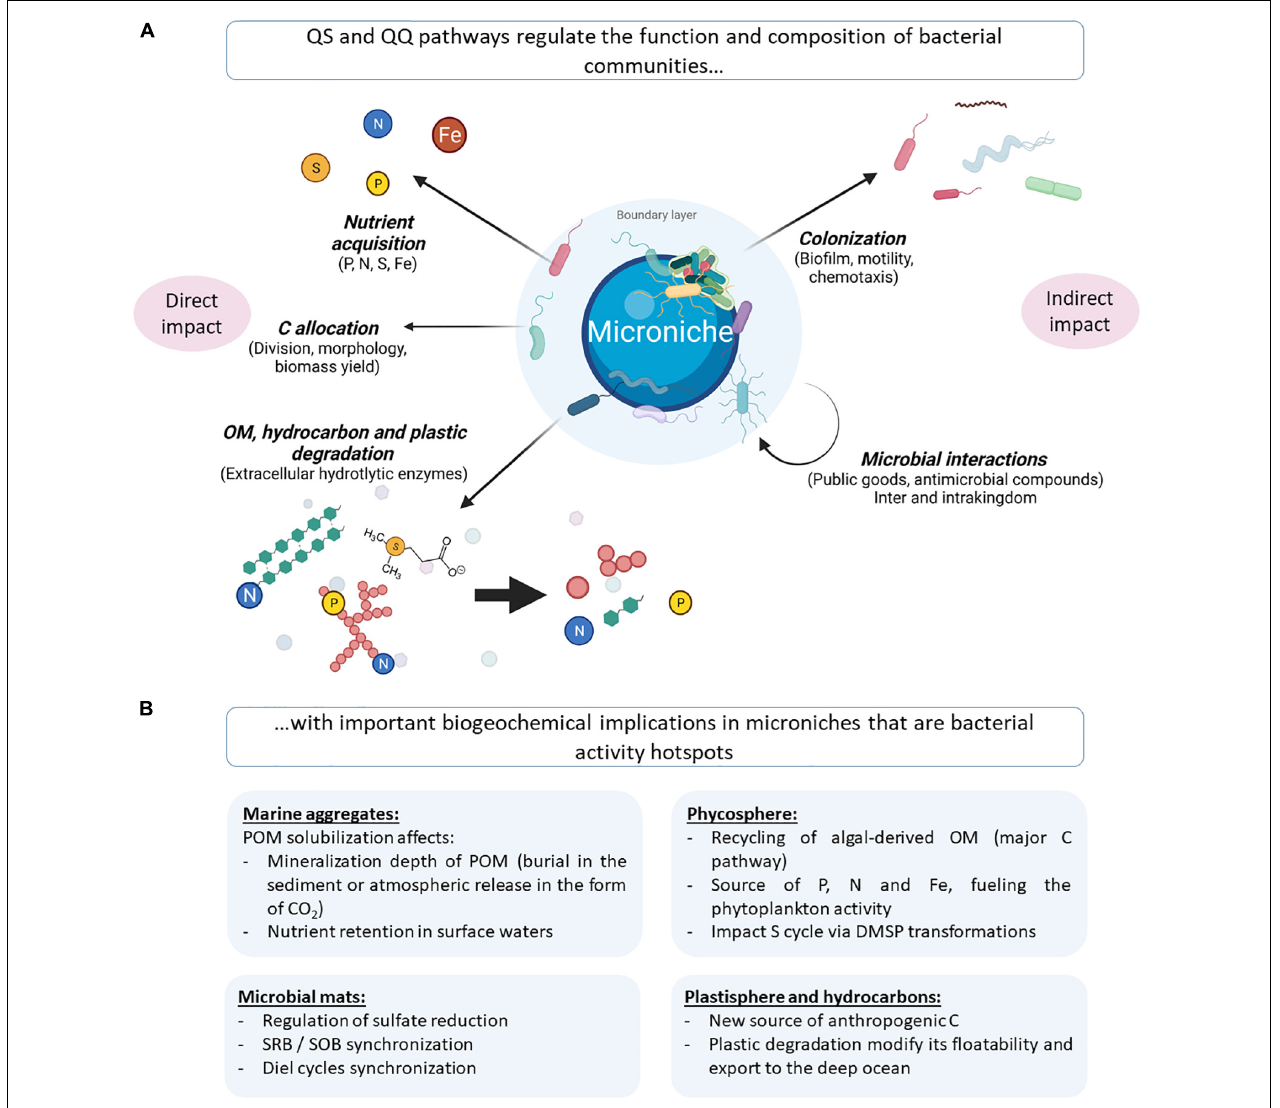
FIGURE 3 | (A) Illustration of QS-regulated processes that potentially impact biogeochemical cycles, either directly through the modulation of OM degradation and nutrient acquisition (left) or indirectly through the modulation of the microbial composition (right). (B) Illustration of the repercussions of the highlighted QS-regulated processes in microniches that are bacterial activity hotspots. OM, organic matter; POM, particulate organic matter; DMSP, dimethylsulfoniopropionate; SRB, sulfate-reducing bacteria; SOB, sulfide-oxidizing bacteria. Created with